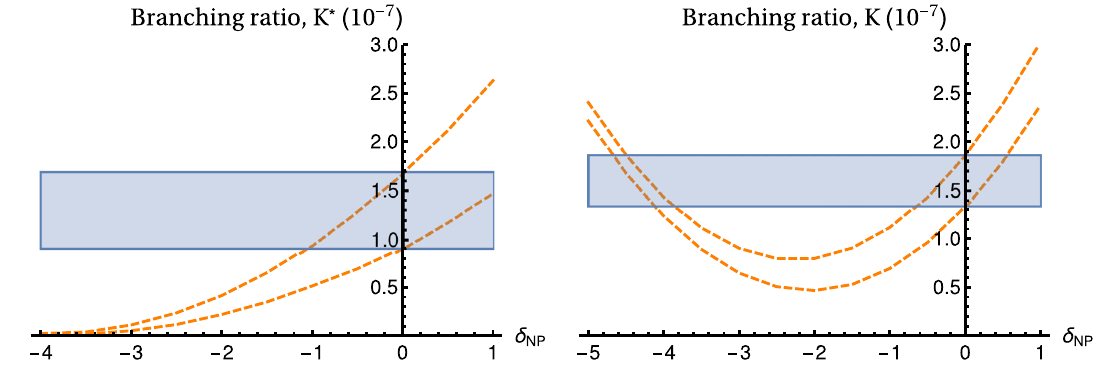
Fig. 9 New physics effects in the form of a real δ C 9 = − δ C 10 ≡ δ NP , whose values are given in the horizontal axes. See Figs. 4, 7 for more comments on the reading of the graphics